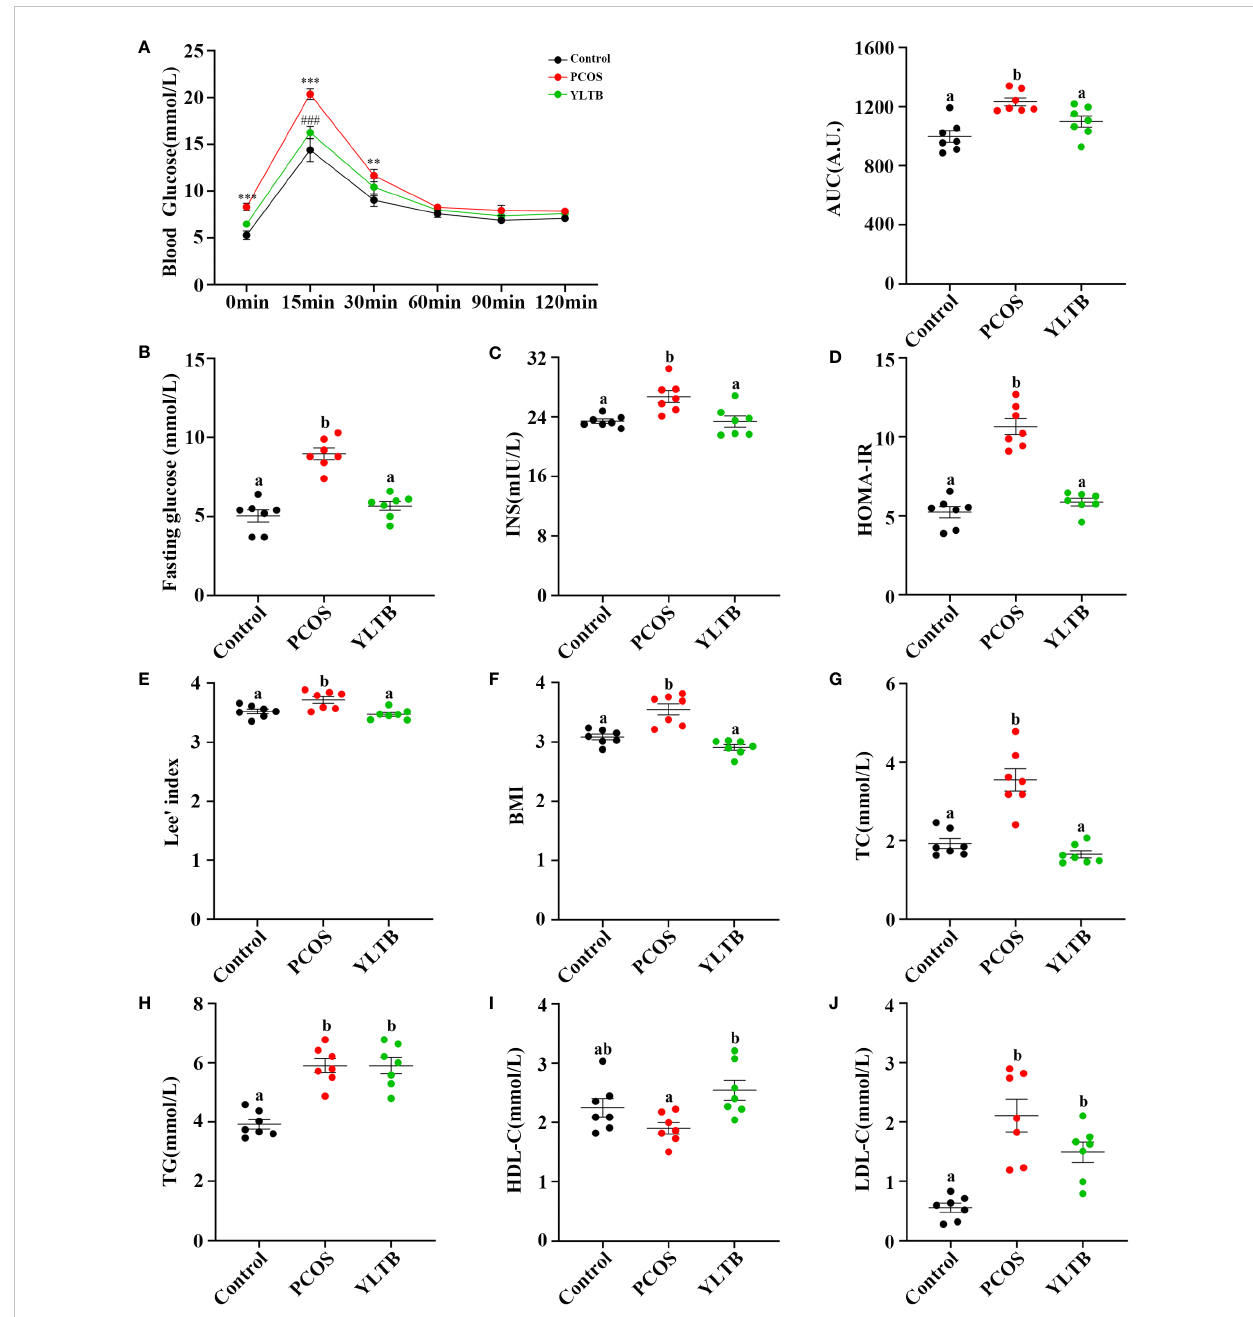
FIGURE 3 The effects of YLTB on glucose tolerance, insulin sensitivity and lipid metabolism in PCOS mice. (A) OGTTs in mice from the control, PCOS, and YLTB groups. The corresponding area under the curve (AUC) values of blood glucose levels in each group were calculated (** P < 0.01; *** P < 0.001 compared with the control group, ### P < 0.001 compared with the PCOS group). (B, C) Blood glucose and serum insulin level assessment after 12 h of fasting in mice from the control, PCOS, and YLTB (38.68 g·kg -1 ·day -1 ) groups. (D) The homeostasis model assessment of insulin resistance (HOMA-IR) index = [FBG (mmol/L)] × [FINS (lU/mL)]/22.5 in mice from the control, PCOS, and YLTB groups. (E, F) Lee ’ s index = [Body mass (g) × 1,000] 1/3 /body length (cm) and Body mass index (BMI = weight (kg)/height (m 2 ) calculation. (G – J) Detection of TC, TG, HDL-C and LDL- C to evaluate the level of serum lipid metabolism in mice from the control, PCOS, and YLTB groups. n = 7/group, statistical signi fi cance was determined using one-way or two-way ANOVA with Tukey ’ s multiple comparisons test, and data are presented as the mean ± SEM. a and b indicate P < 0.05; if 2 groups have the same letter, it indicates no statistical signi fi